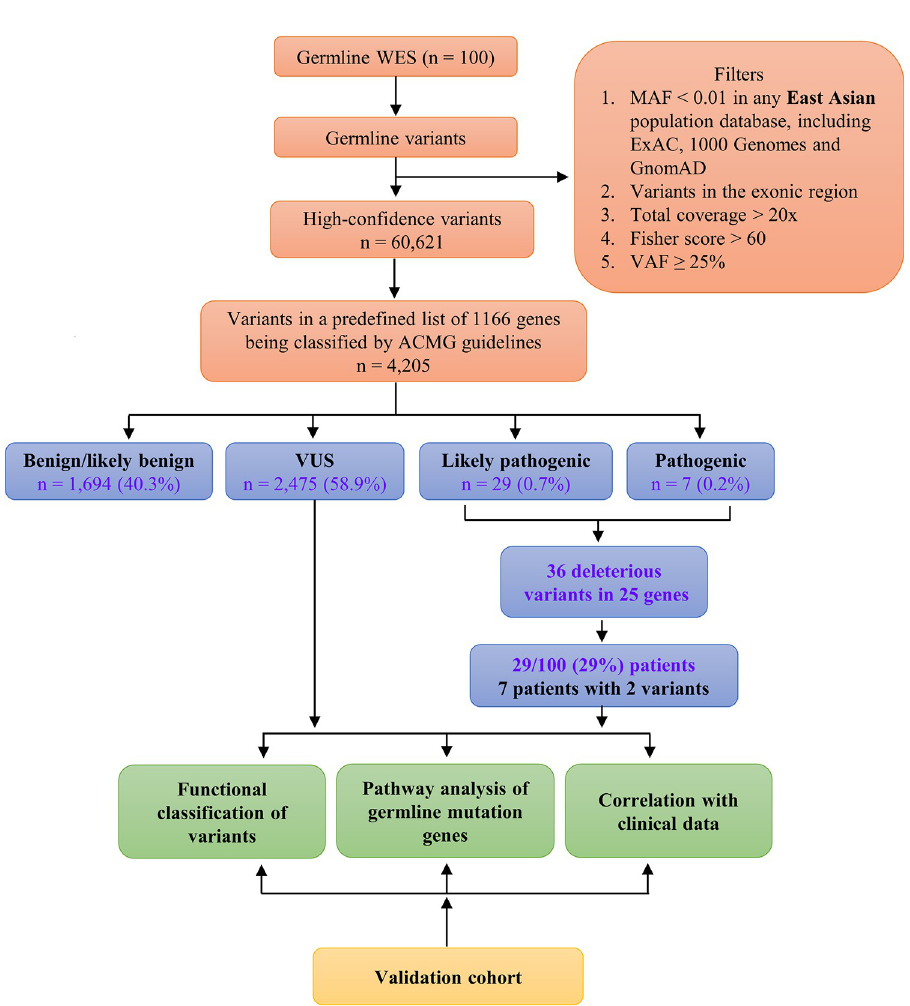
Fig 1. Overview of the data analysis strategy to identify candidate prostate cancer susceptibility genes. A total of 100 Hong Kong patients with prostate cancer were included. The patient characteristics are summarized in Table 1. Germline samples were whole exome–sequenced and aligned to human genome assembly hg19 before variant calling and annotations. All germline variants were identified and filtered by (i) MAF < 0.01 in any East Asian population database including ExAC, 1000 Genomes and GnomAD v2.1., (ii) variants in the exonic region, (iii) variants with total coverage > 20x, (iv) variants with Fisher score > 60, and (v) VAF � 25%. Among the 60,621 variants after filtering, 4,205 variants belonging to a predefined list of 1,166 genes were annotated as pathogenic or likely pathogenic (deleterious), variant of uncertain significance (VUS), likely benign, or benign (benign) according the ACMG guidelines. The 1,166-gene list is provided in S1 Table. We also performed functional classification of variants and correlations with clinical characteristics of patients. Our data were validated with an independent prostate cancer cohort (n = 167 patients). MAF, minor allele frequency; VAF, variant allele